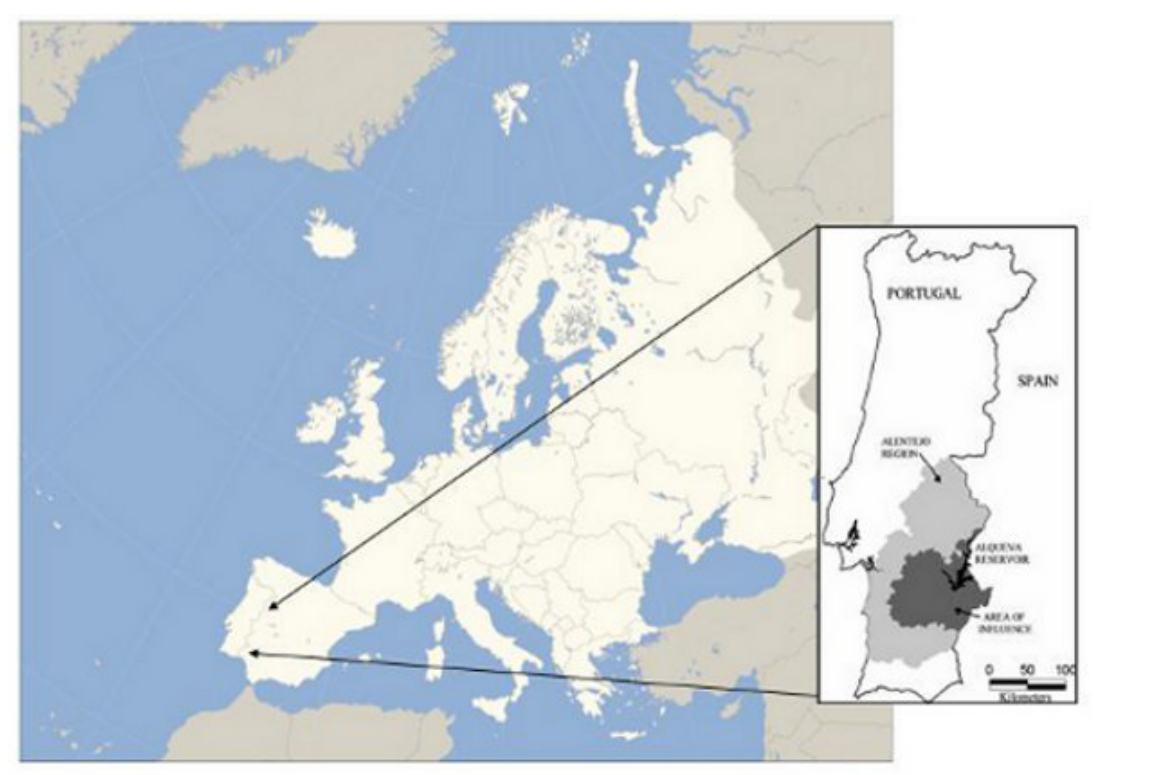
Fig. 3 . Map depicting (in gray) the Alentejo region of southern